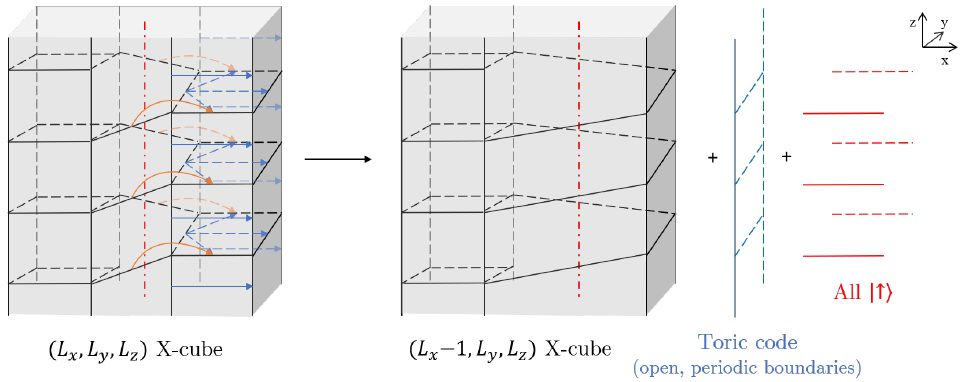
Figure 16: The entanglement RG process to remove a toric code leaf adjacent to a screw dislocation. The arrows denote CNOT gates as in Fig. 10. (Colored for